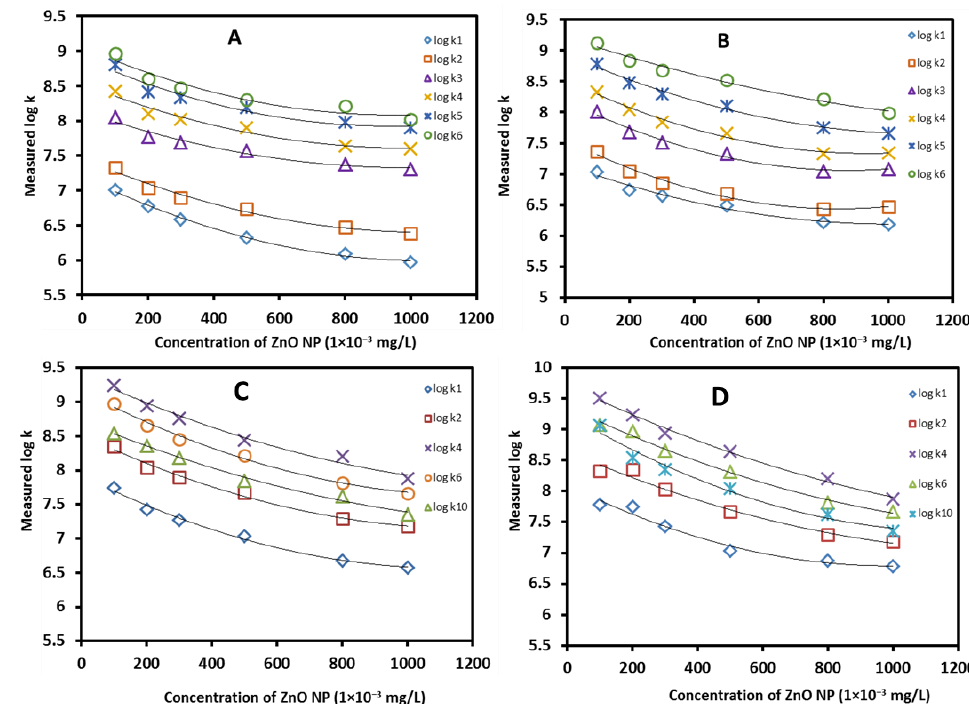
Figure 9. Effect of the concentration of ZnO NPs on adsorption for aromatic organochlorines. Concen- trations of ZnO NP from 0.1 to 1 mg/L. ( A ) Chlorobenzene concentration at 0.01 mg/L, adsorption coefficients for chlorobenzenes from 1 Cl atom (log k 1) to 6 Cl atoms (log k 6). ( B ) Chlorobenzene concentration at 0.05 mg/L, adsorption coefficients for chlorobenzenes from 1 Cl atom (log k 1) to 6 Cl atoms (log k 6). ( C ) PCB concentration at 0.01 mg/L, adsorption coefficients for PCBs from from 1 Cl atom (log k 1) to 10 Cl atoms (log k 10). ( D ) PCB concentration at 0.05 mg/L, adsorption coefficients for PCBs from from 1 Cl atom (log k 1) to 10 Cl atoms (log k